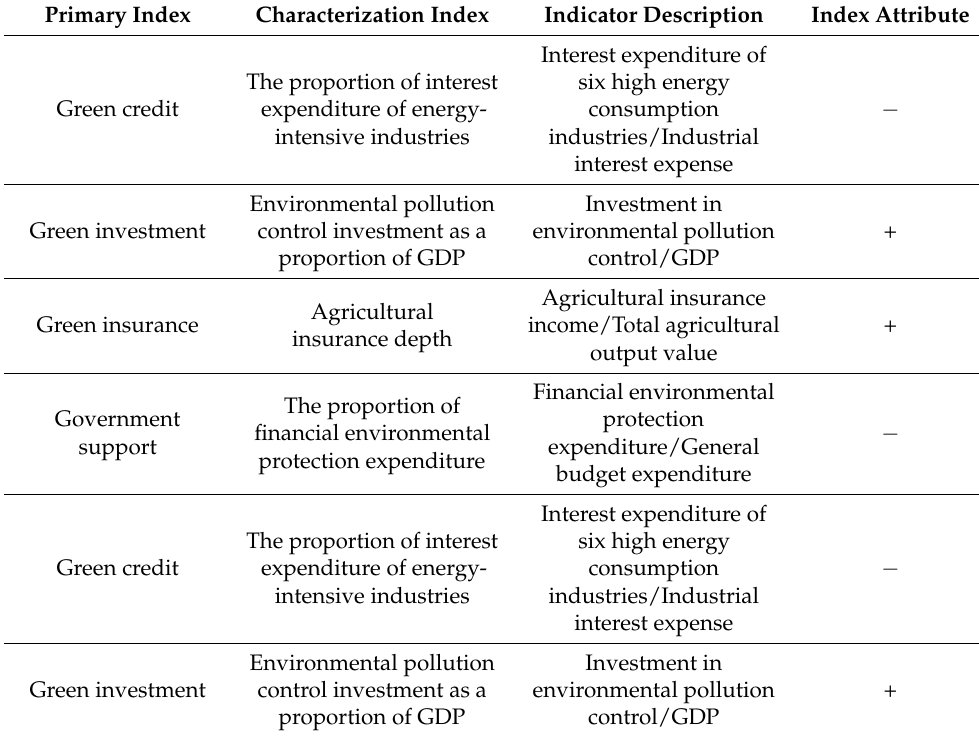
Table 3. The definition and attribute of the green financial